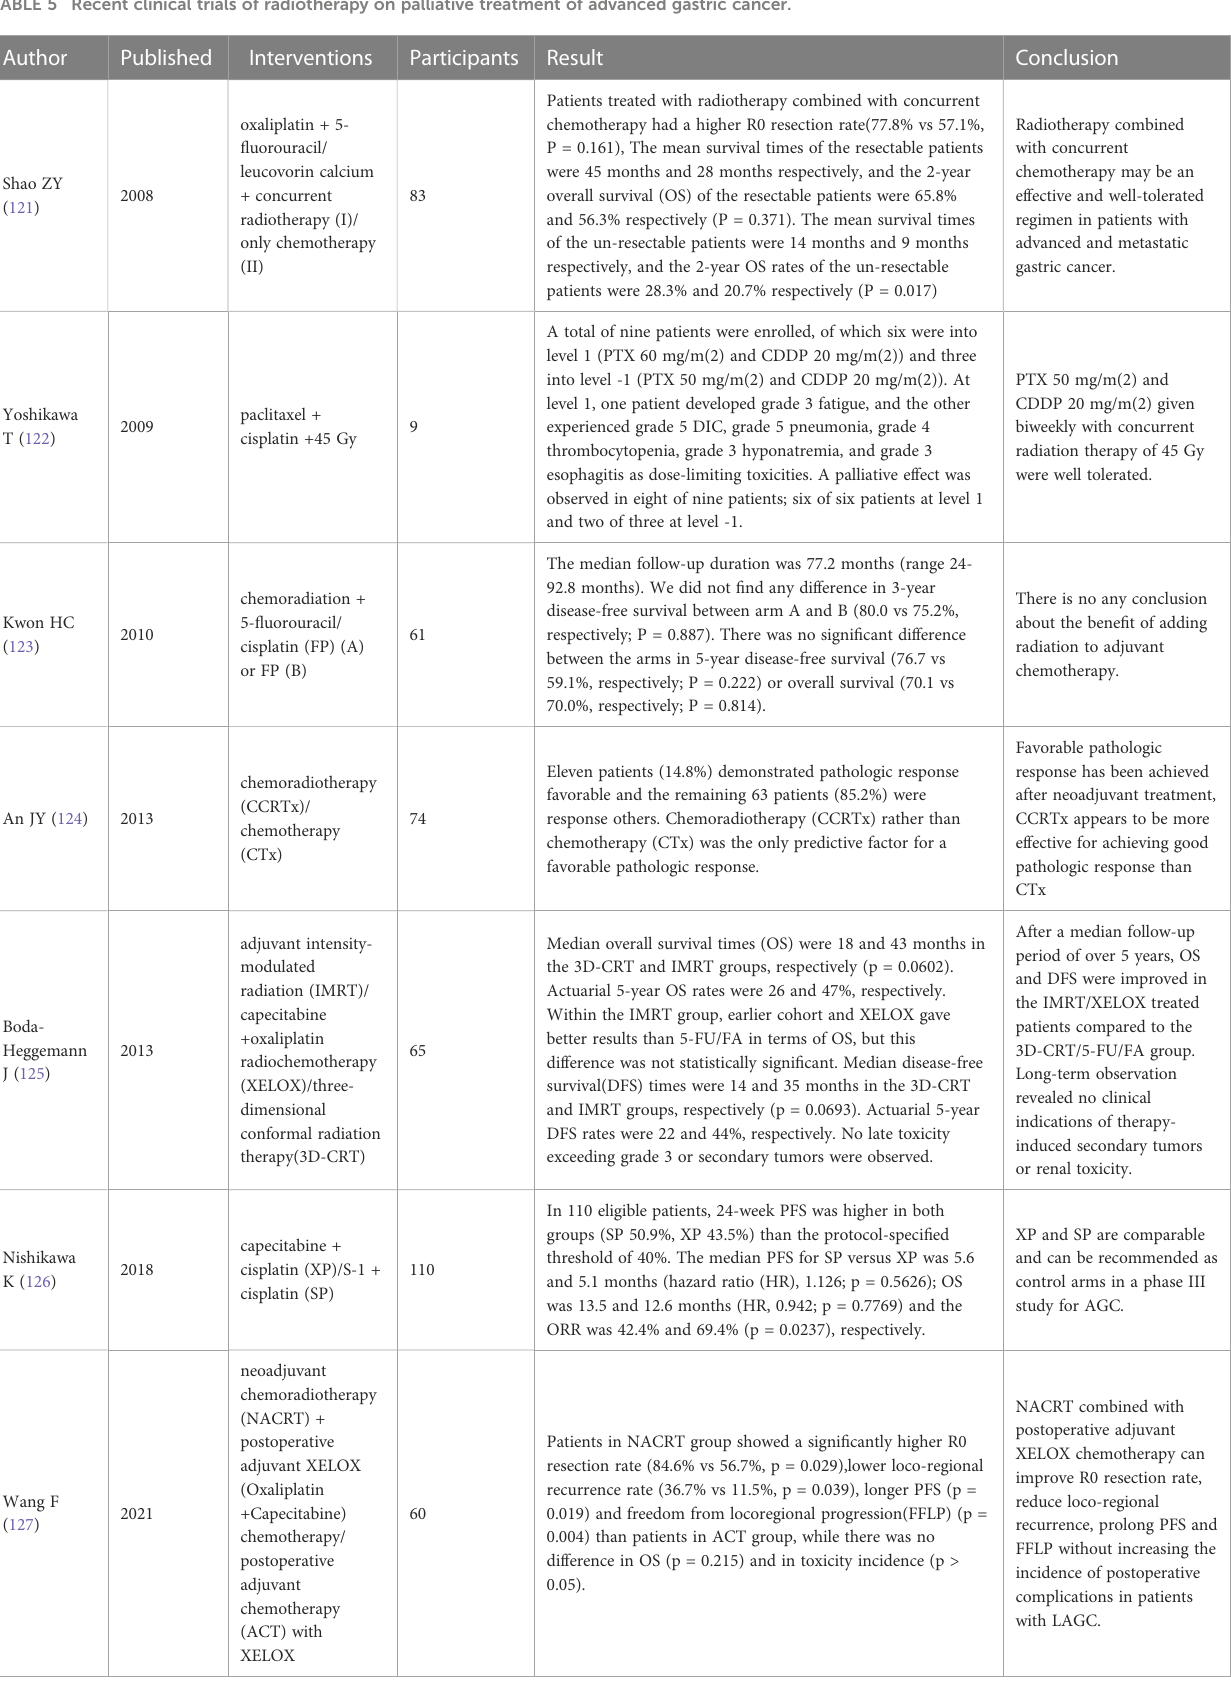
TABLE 5 Recent clinical trials of radiotherapy on palliative treatment of advanced gastric